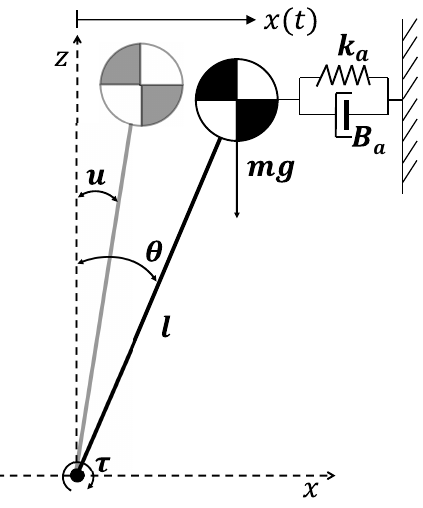
Figure 15. Proposed compensated inverted pendulum